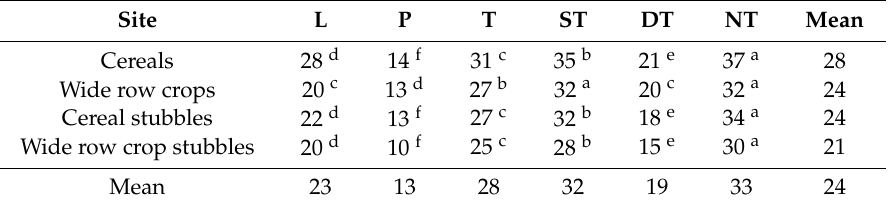
Table 5. Earthworm abundance (ind m − 2 ) at di ff erent agronomic sites.